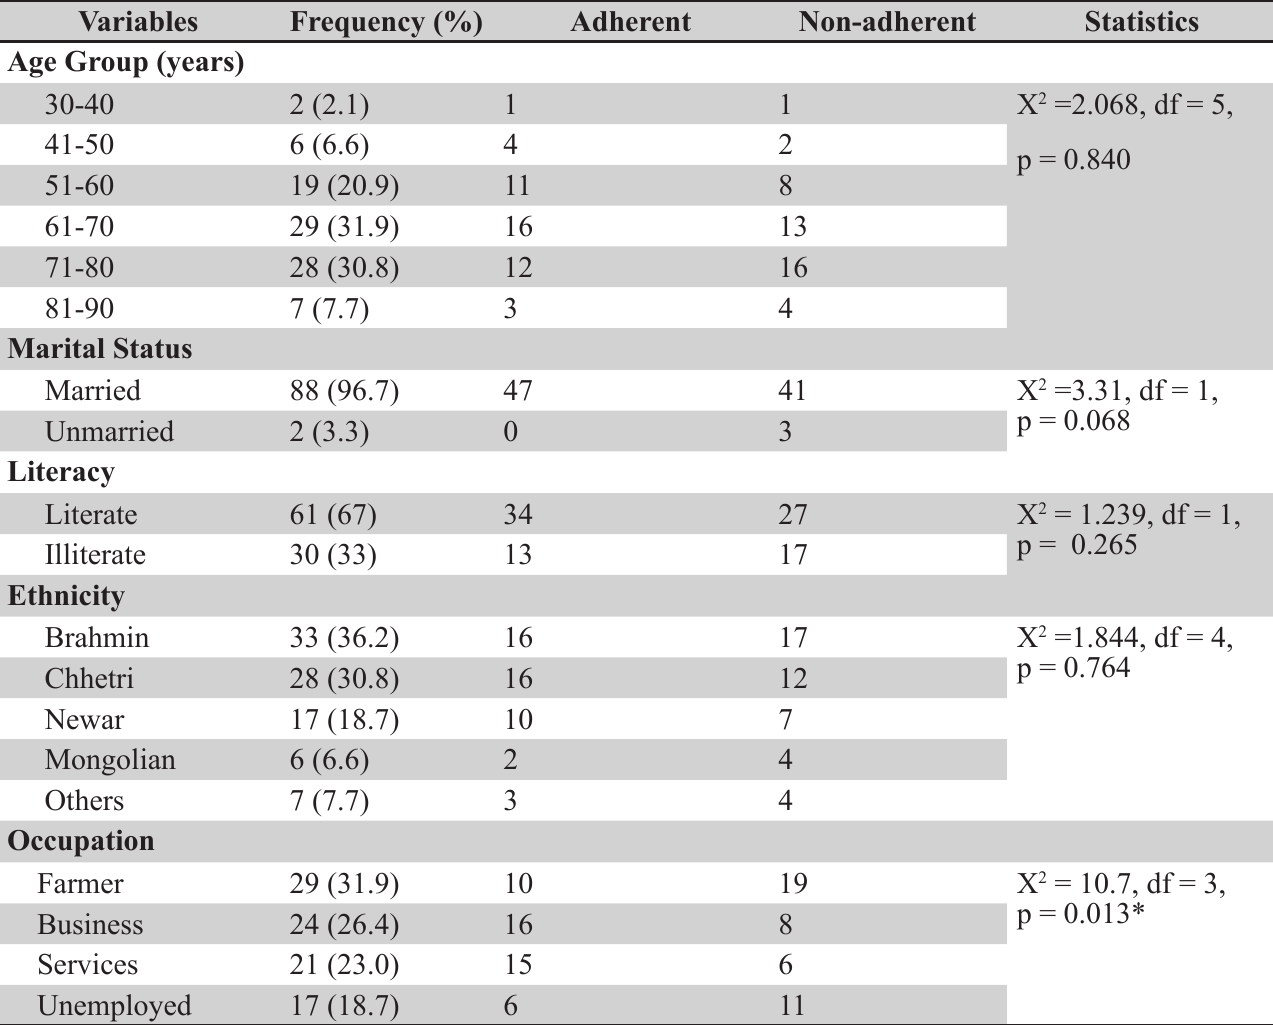
Table 1. Demographic characteristics and adherence to treatment (N = 91)